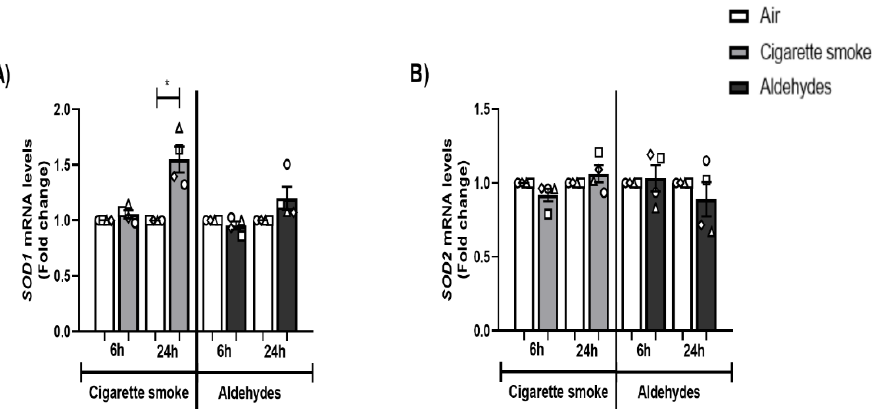
Figure 2. CS exposure affects expression of antioxidant genes. Differentiated human primary bronchial epithelial cells (PBEC) from non-COPD subjects ( n = 4 donors) were exposed to smoke of one Marlboro Red cigarette (CS) or a mixture of acetaldehyde, acrolein, and formaldehyde (at concentrations equivalent to one cigarette) or air (control), under a continuous flow system using a puff-like exposure protocol. Following recovery for 6 h or 24 h, whole cell lysates were harvested for transcript analysis of oxidative stress markers ( A ) SOD1 and ( B ) SOD2 . Data are presented as mean fold change compared to air control ± s.e.m. The mean values of biological triplicate results per independent donor are represented by open circles, triangles, squares, or diamonds. Statistical differences between CS vs. air and a mixture of aldehydes vs. air were tested using a two-tailed paired parametric t -test. Statistical significance is indicated as * p < 0.05 vs. air (control).